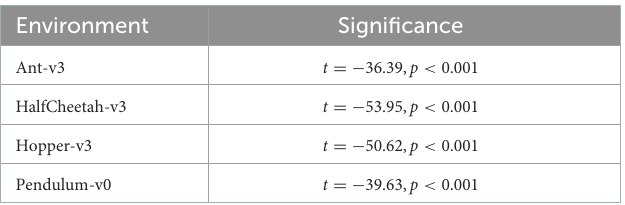
TABLE 3 Random membrane parameters significance